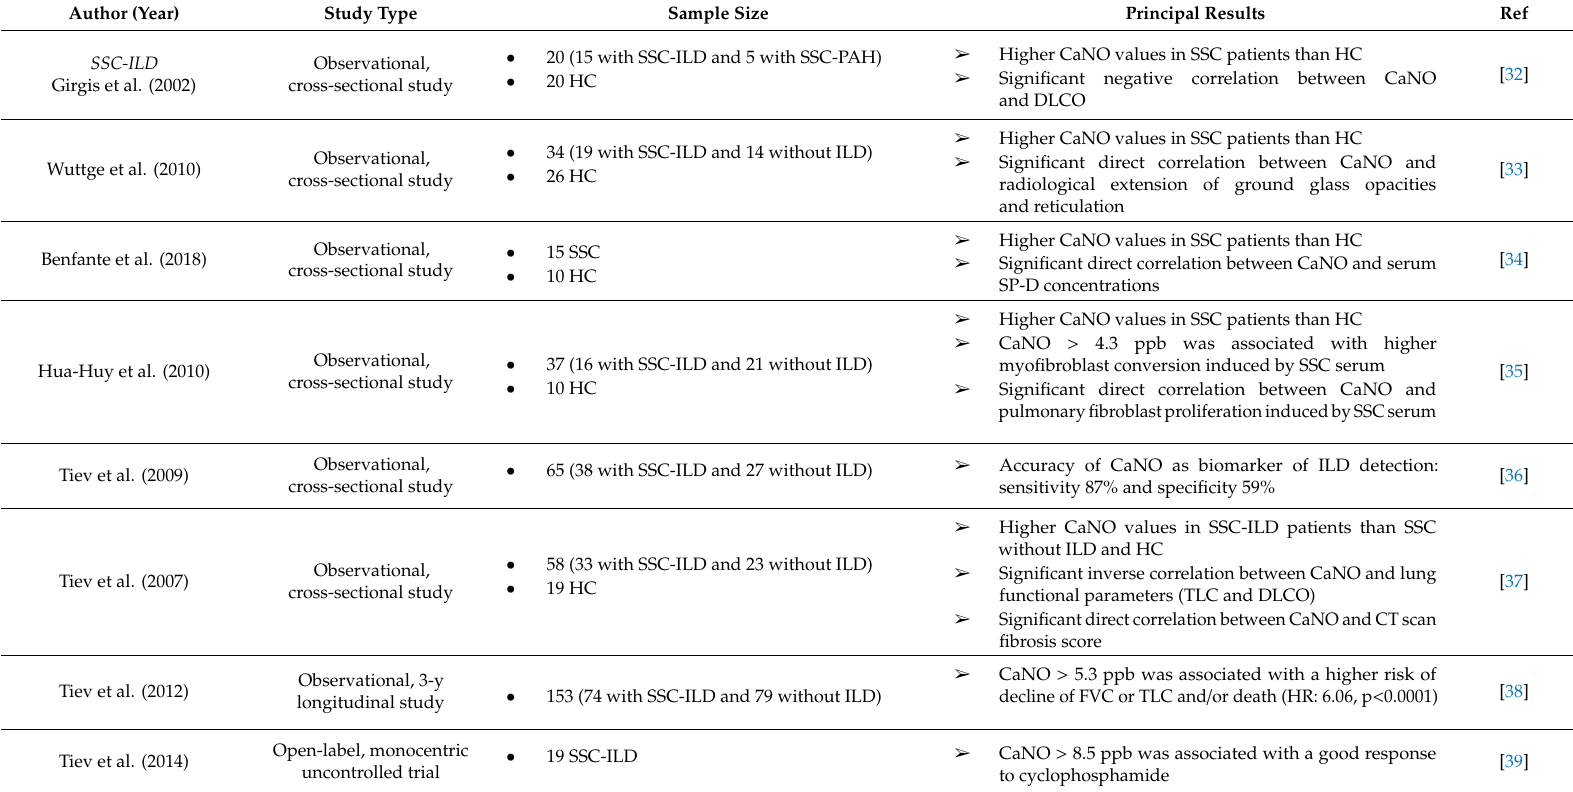
Table 1. Characteristics of included studies focusing on the evaluation of extended FeNO analysis in humans for di ff erent ILDs. SSC-ILD: systemic sclerosis associated interstitial lung disease; PAH: pulmonary arterial hypertension; CaNO: alveolar concentration of nitric oxide; FeNO: fractional exhaled nitric oxide; DLCO: di ff usion lung capacity for carbon monoxide; HC: healthy controls; SP-D: surfactant protein-D; TLC: total lung capacity; FVC: forced vital capacity; IPF: idiopathic pulmonary fibrosis; CTD-ILD: connective tissue disease associated interstitial lung disease; NSIP: non-specific interstitial pneumonia; cHP: chronic hypersensitivity pneumonitis; COP: cryptogenic organizing pneumonia; RB-ILD: respiratory bronchiolitis associated interstitial lung disease; IVC: inspiratory vital capacity; CPFE: combined pulmonary fibrosis and emphysema; 6MWD: 6-min walking distance; CPI: combined physiological